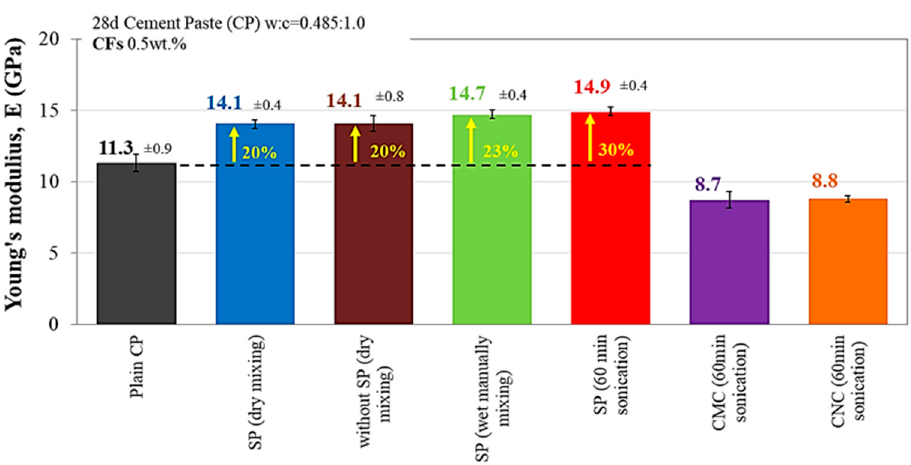
Figure 7. Young’s Modulus of 28-day plain cement pastes and CFs reinforced cementitious compo- sites.